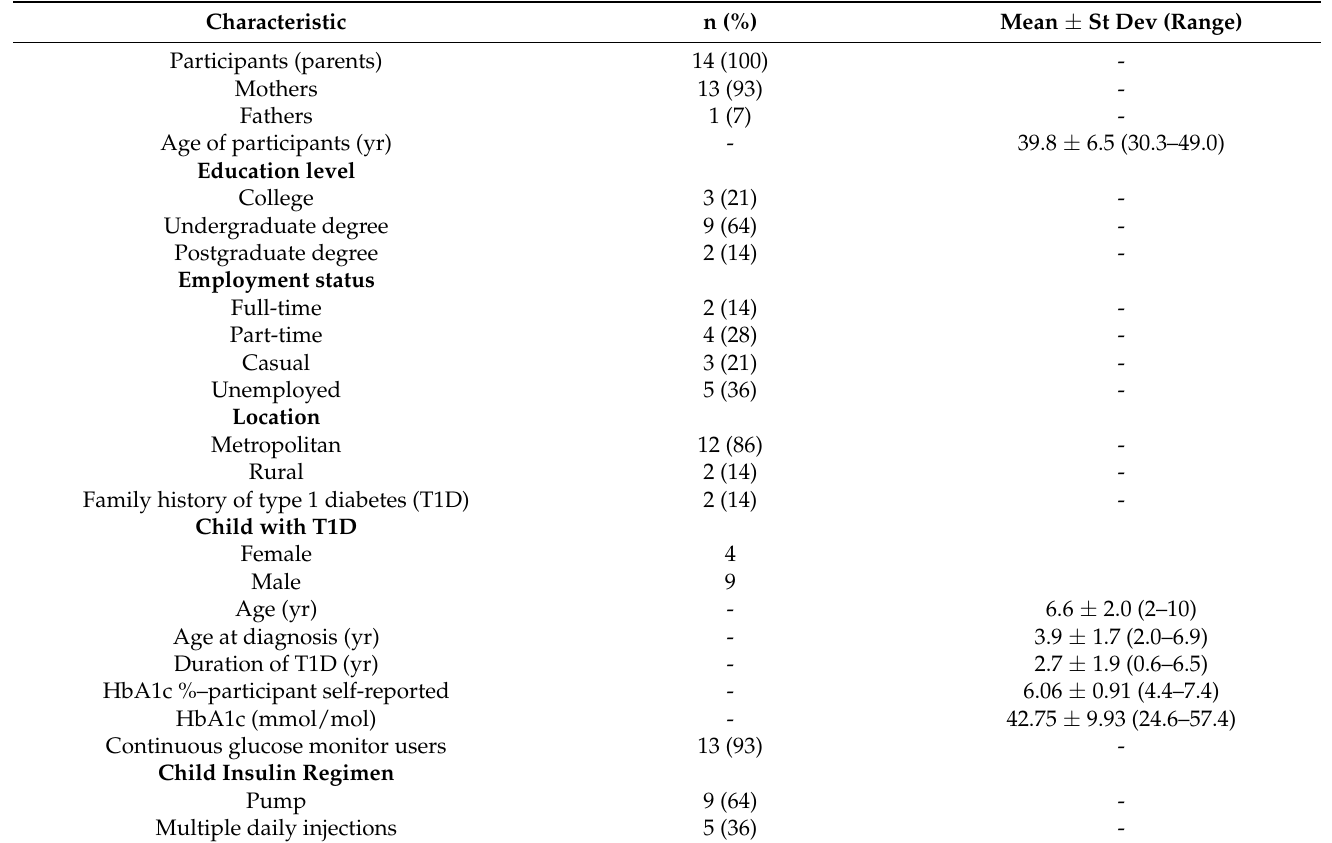
Table 1. Characteristics of parent participants ( n = 14) and their children ( n =